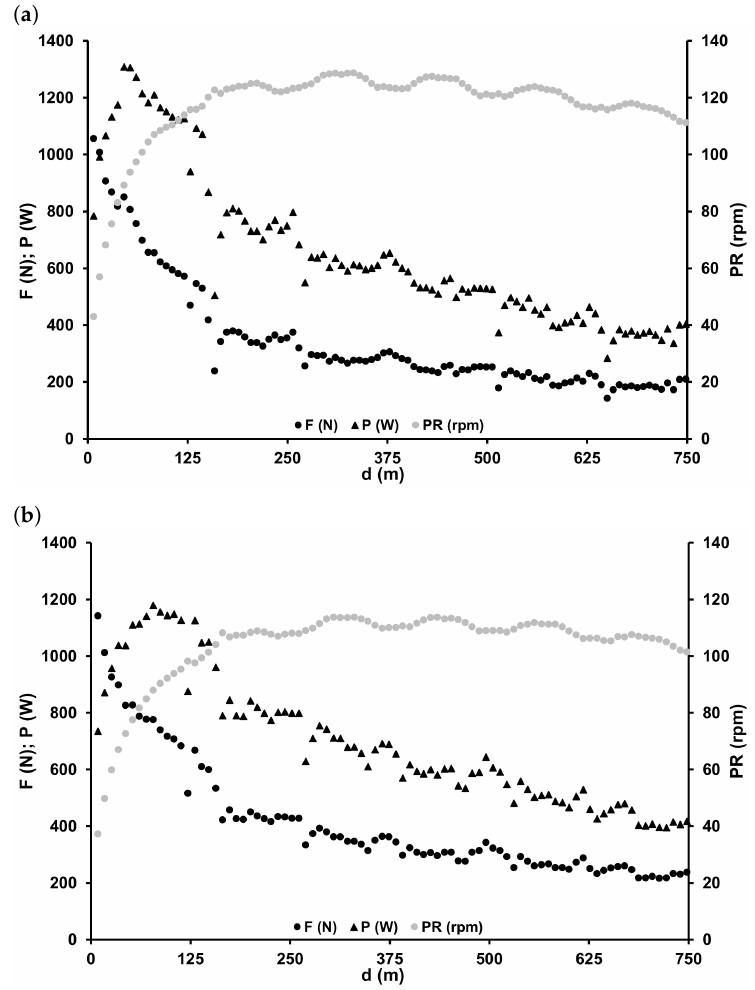
Figure 2. Mean pedal force F T , pedalling rate PR and power output P during two 750m time trials. ( a ) First run at the development of 7.56m per pedal revolution, ( b ) second run at the development of